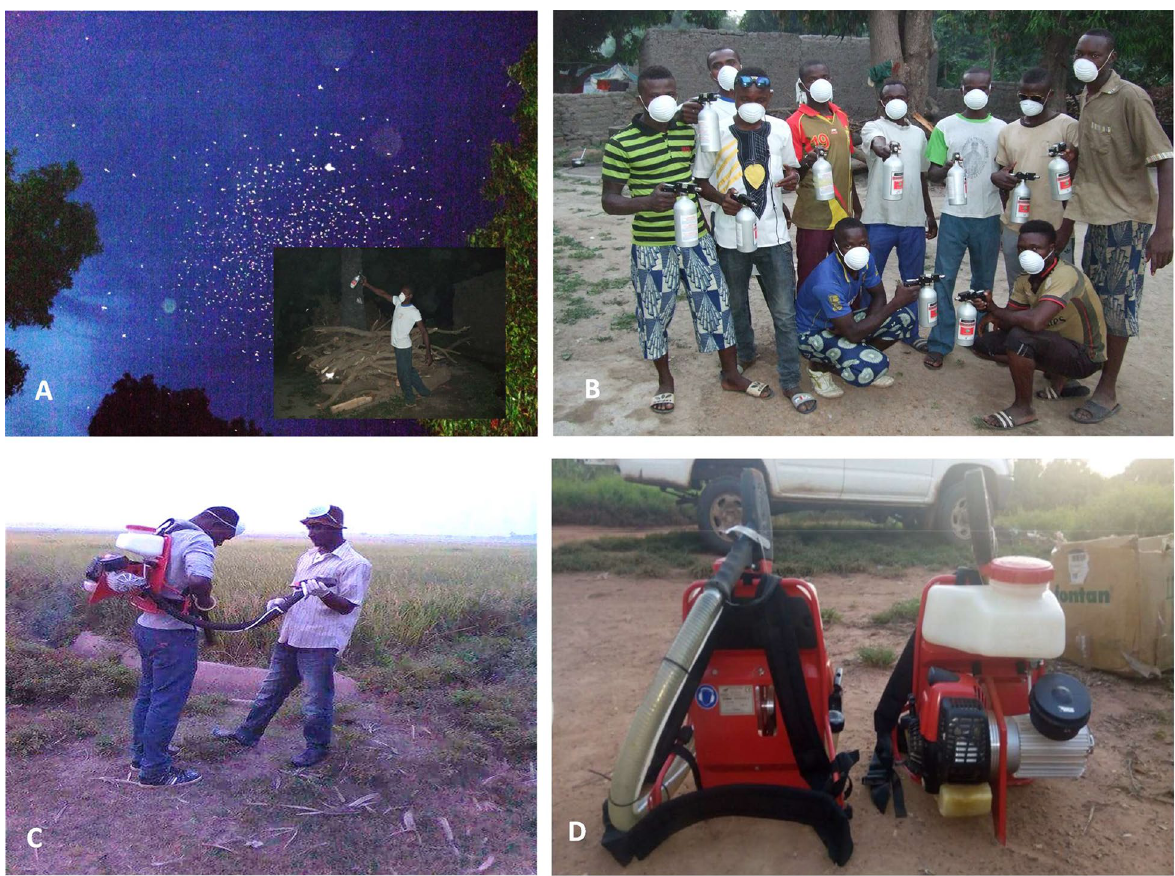
Figure 2. Volunteer spraying swarms using handheld sprayers ( A , B ). Backpack spraying activities ( C , D